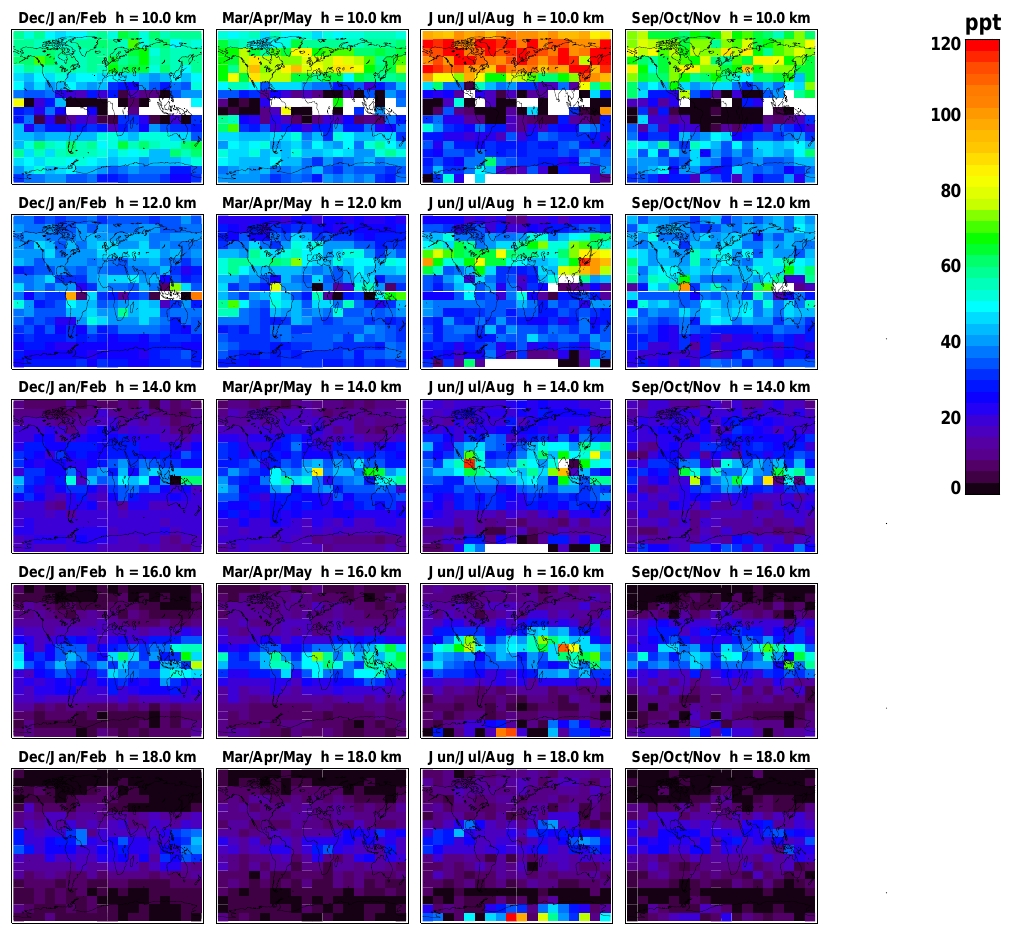
Figure 16. Seasonal global SO 2 background distributions at different altitude levels based on all MIPAS observations. The